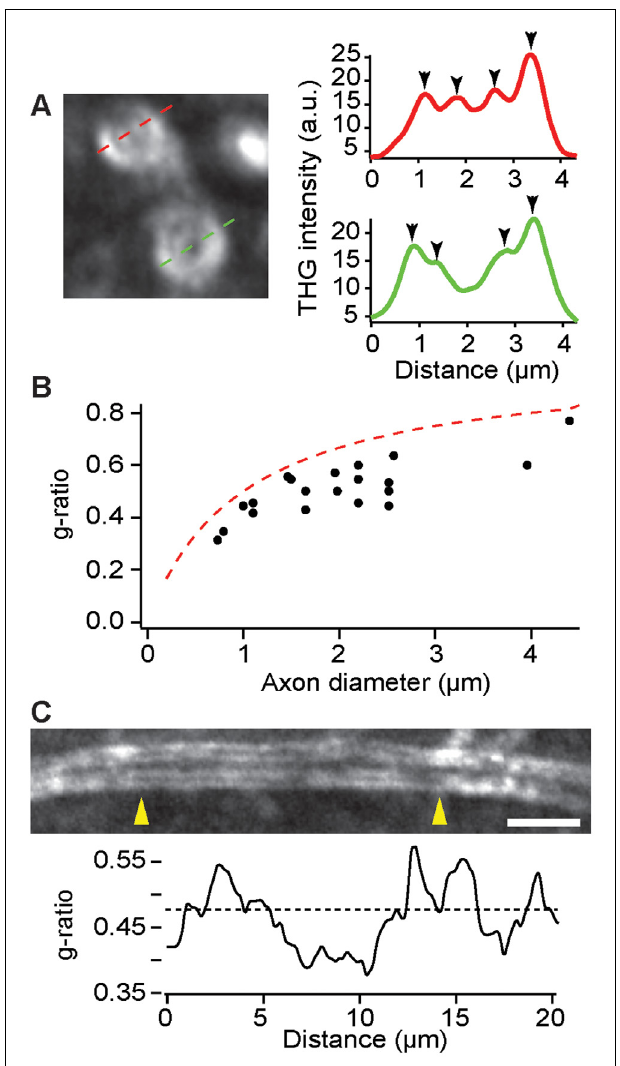
FIGURE 5 | Evaluation of the g-ratio in the deeper cortex by THG. (A) The cross sections of myelinated axons (left) and the corresponding intensity profiles (right). The position of adaxonal and abaxonal membranes can be precisely determined (arrowheads, right). (B) The g-ratio vs. the axon diameter for a total of 20 axons in layer 6 of the primary motor cortex (M1) of C57BL/6 mice ( N = 5). The dashed line is for the case of a 0.5- µ m myelin sheath. (C) A single internode at a depth of approximately 500 µ m exhibiting variations of the g-ratio across the length between arrowheads (yellow). The dashed line denotes the average g-ratio. Scale bar, 5 µ